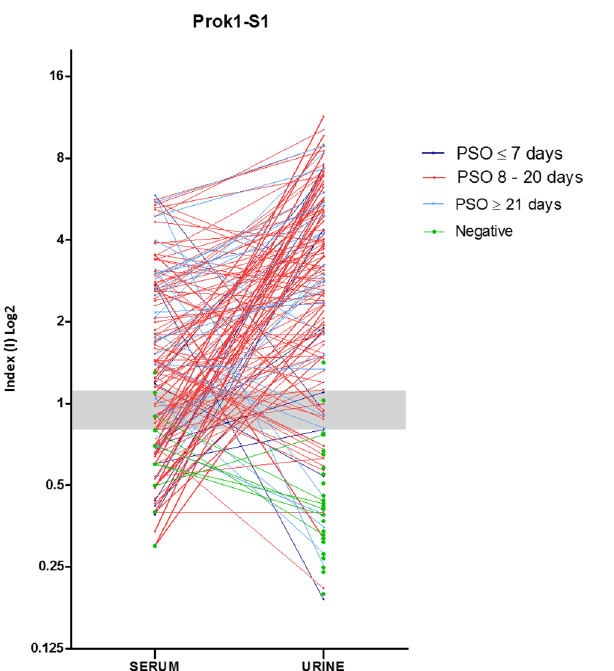
Figure 4. Evaluation of comparative urine and serum index values (I) for each patient according to the days post-symptoms onset (PSO) by using rSARS-CoV-2 Prok1-S1 protein. The index values obtained from urine and serum samples for each patient are represented by circles and when paired they are interconnected by lines, each color being specific to the collection period after the onset of symptoms Individual data were divided according to the PSO days of the collection date, i.e. at ≤ 7 days, 8 to 20 days and ≥ 21